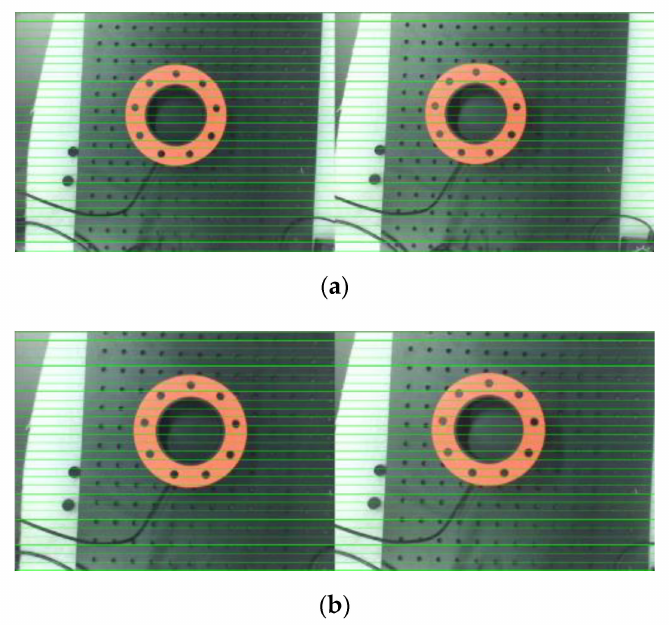
Figure 13. The resulting images after stereoscopic correction: ( a ) the binocular image before correction; and ( b ) the binocular image after